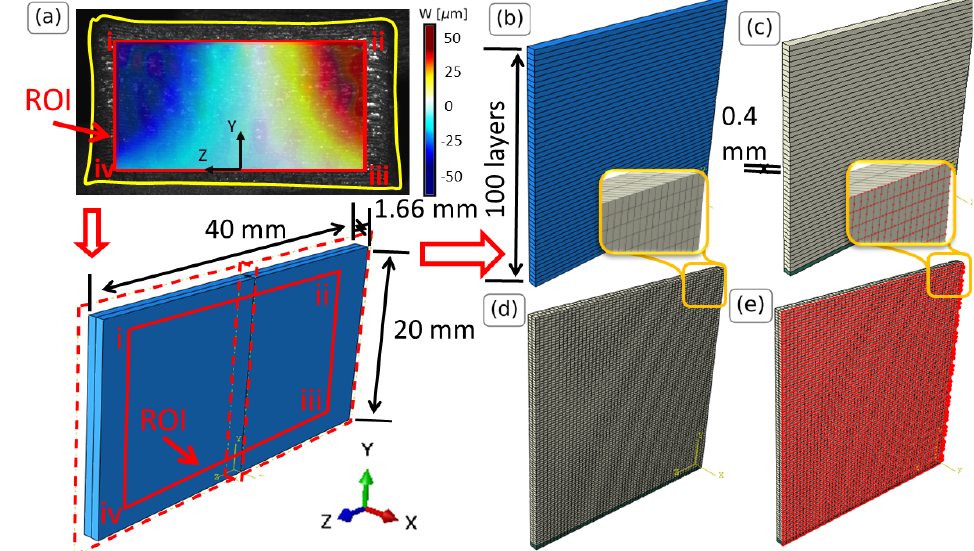
Figure 4. FE model of the thin-wall specimens. ( a ) Creating and partitioning of the full model due to symmetry, ( b ) thickness of printed layers, ( c ) addition of steel material (in white) and stiff base material (in green), ( d ) meshed structure, ( e ) nodes (in red) from which the displacements are